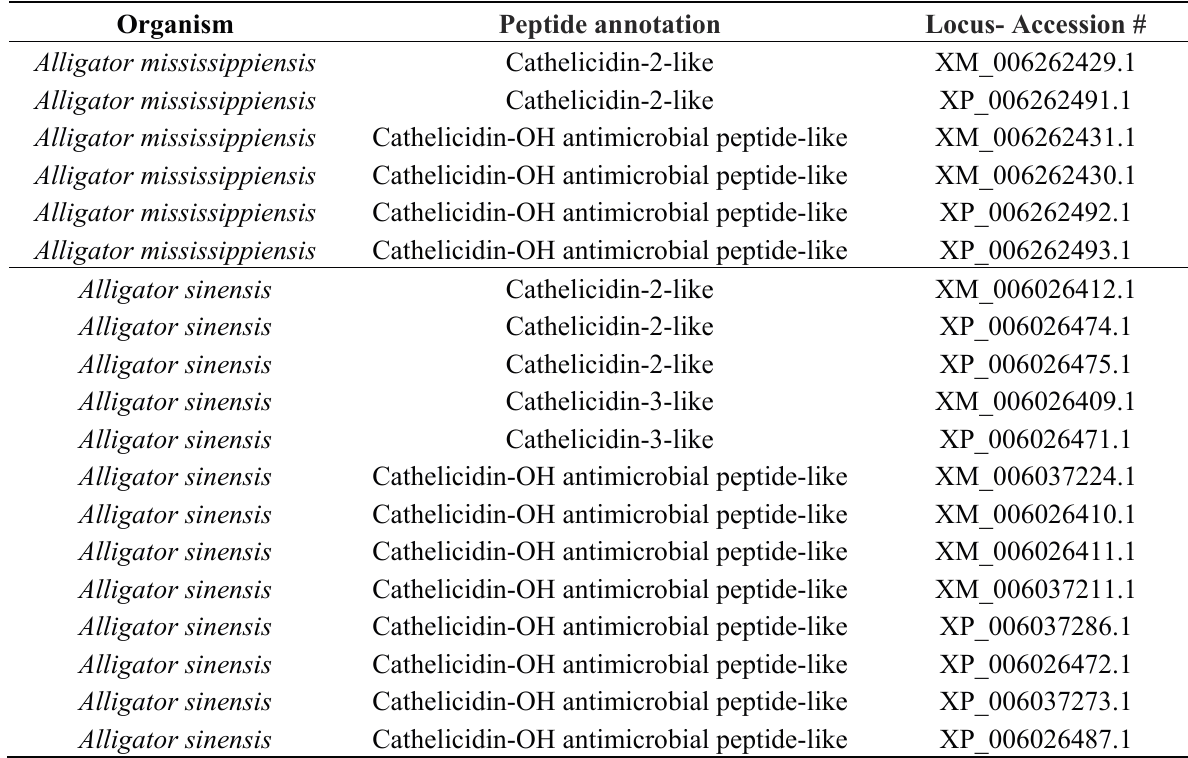
Table 6. Predicted cathelicidin pre-pro-protein genes in Alligator